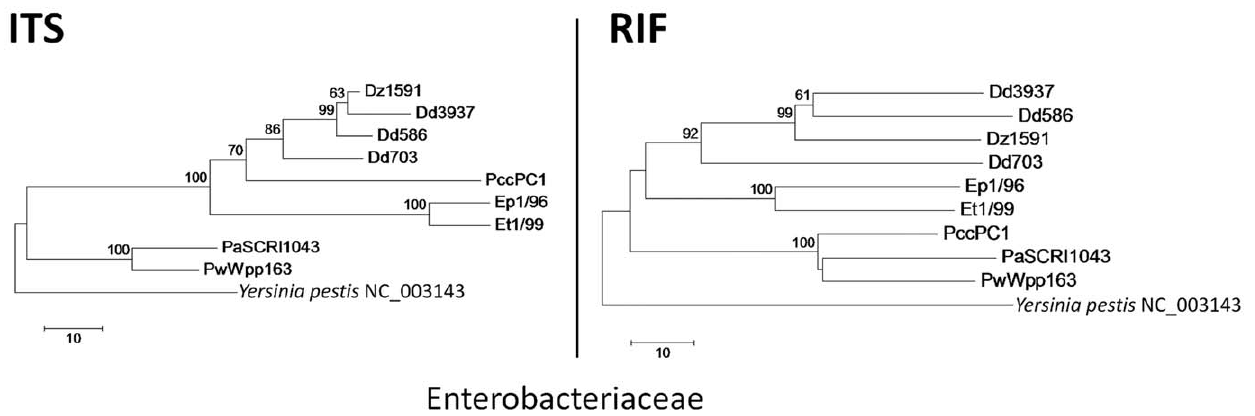
Figure 6. Neighbor-joining cladograms for the family Enterobacteriaceae using ITS and RIF sequences. Sequences for Dickeya , Pectobacterium , Pantoea and Erwinia were extracted from fully sequenced strains in GenBank (Table 1). Bootstrap values . 50% (shown at the node) are expressed as a percentage of 5,000 replicates. Note the longer branch lengths for the Erwinia and Dickeya species in the RIF tree.